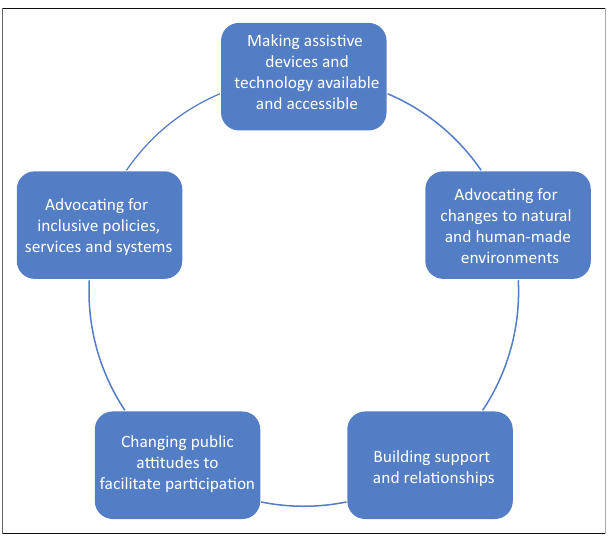
FIGURE 2: Measures and strategies linked to the International Classification of Functioning, Disability and Health: Children & Youth Version categories of environmental